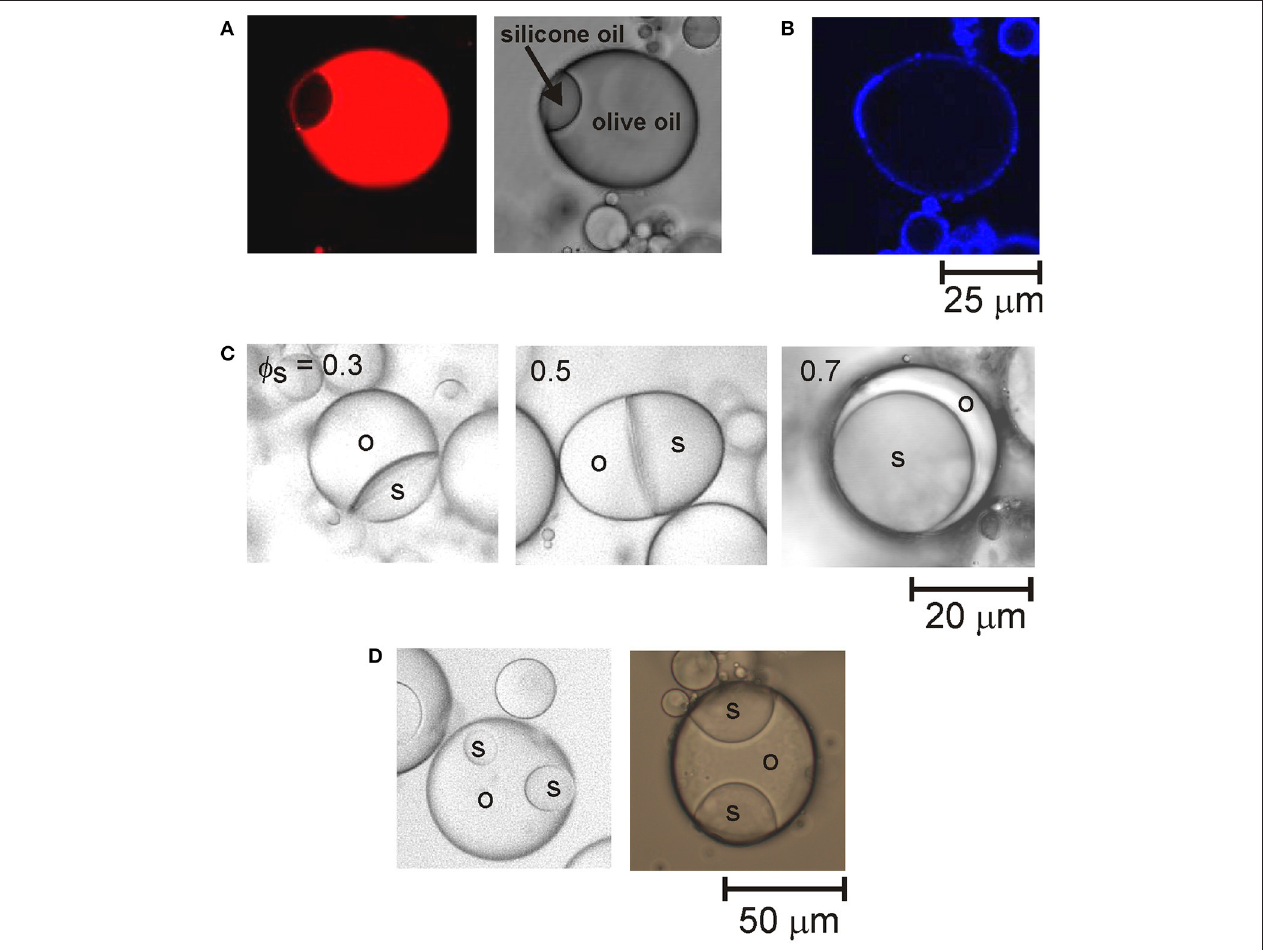
FIGURE 2 | (A) Confocal fluorescence image (left) and an optical microscope image (right) of a fused droplet of olive oil and silicone oil. The confocal image shows the fluorescence from the Nile Red staining the olive oil compartment. (B) Confocal fluorescence image of the particle shell encapsulating the fused droplet shown in (A) . (C) Optical microscope images of fused droplets of olive oil (o) and silicone oil (s) at different volume fractions of silicone oil ( φ s ) in the compound drops. The curvature of the interface between the two oil compartments changes from concave to planar to convex as the volume fraction of the silicone oil compartment increases. (D) Optical microscope images of fused droplets containing more than two